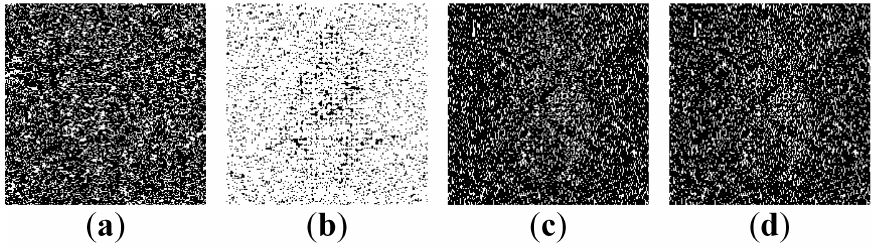
Figure 10. The sensitivity of the communication scheme to the perturbation of system’s parameters. The difference images are shown when: ( a ) a ex = 0 . 021 is used instead of 0 . 02 ; ( c ) n = 21 is used instead of 20 ; ( d ) τ = 19 is used ( b ) a con 0 instead of 20